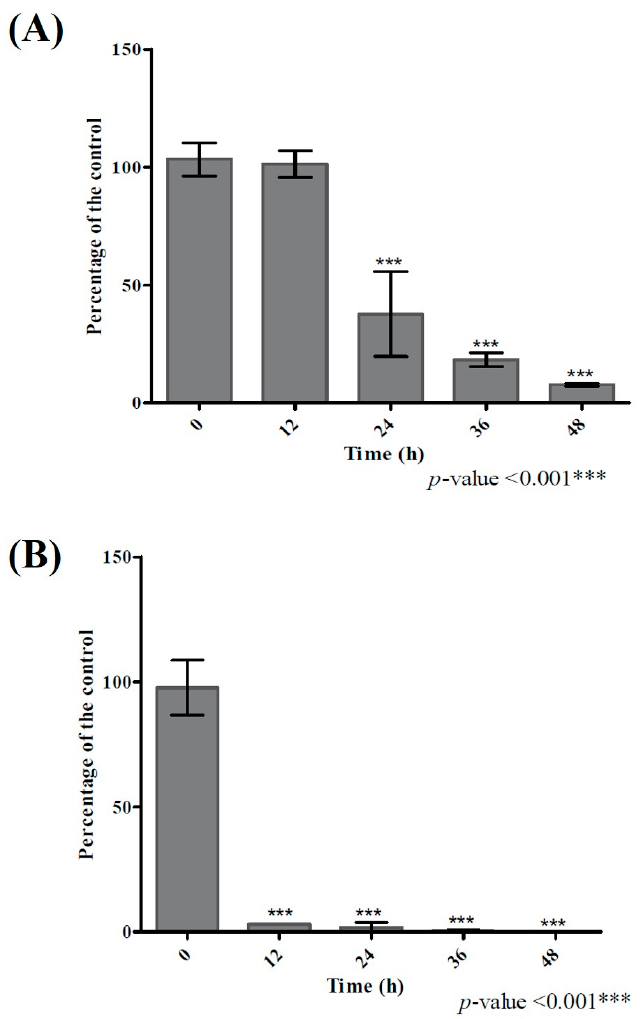
Figure 3. Quercetin degradation patterns of different bacterial species. Kinetics of quercetin degra- dation by ( A ) B. glycinifermentans and ( B ) F. plautii .